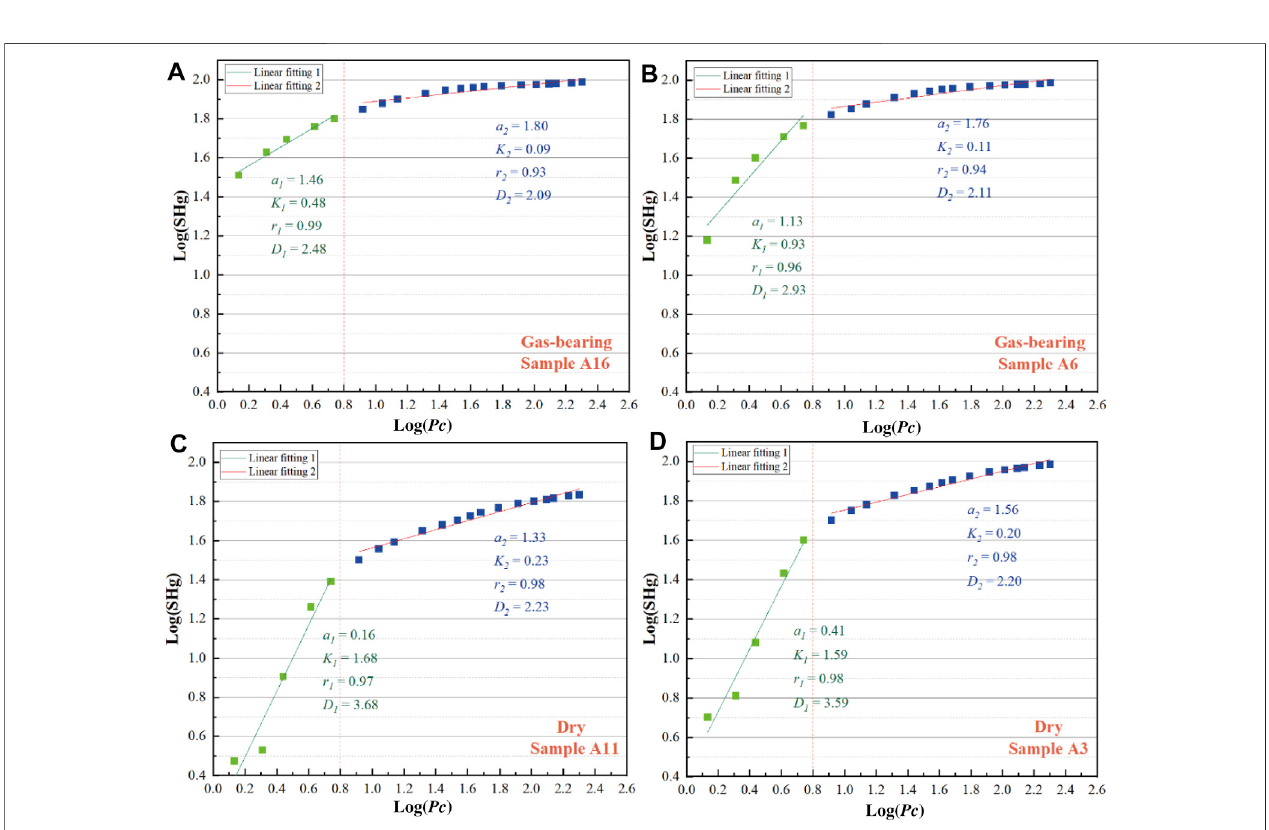
FIGURE 8 | Three-dimensional fractal analysis on HPMI data of typical gas-bearing (A,B) and dry samples (C,D) .